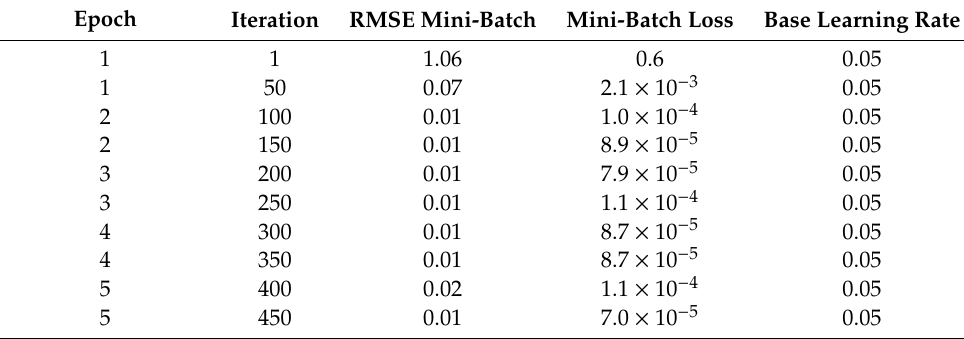
Table 5. Layers of the LSTM after feature extraction.